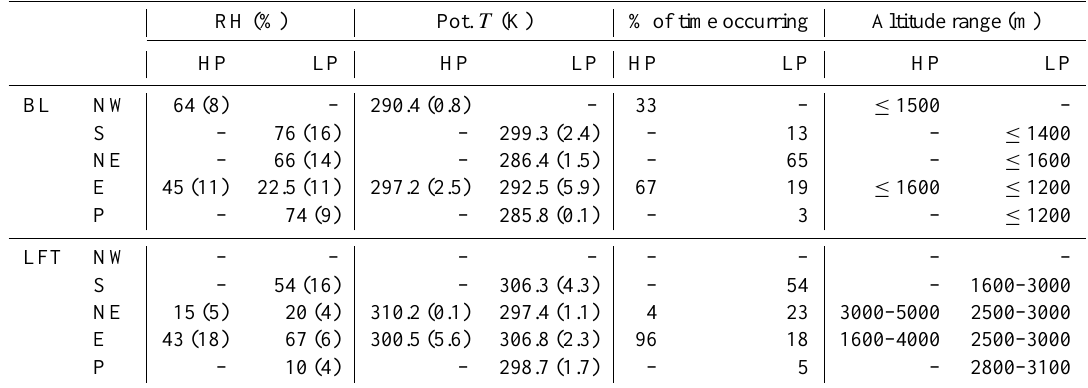
Table 1. Averaged meteorological parameters observed in the boundary layer (BL) and in the lower free troposphere (LFT) for different episodes during anticyclonic (HP) and cyclonic (LP) conditions and for the different air mass sectors (NW: north-west Europe; S: south Europe; NE: north Europe; E: east Europe; P: polar). – = not observed.